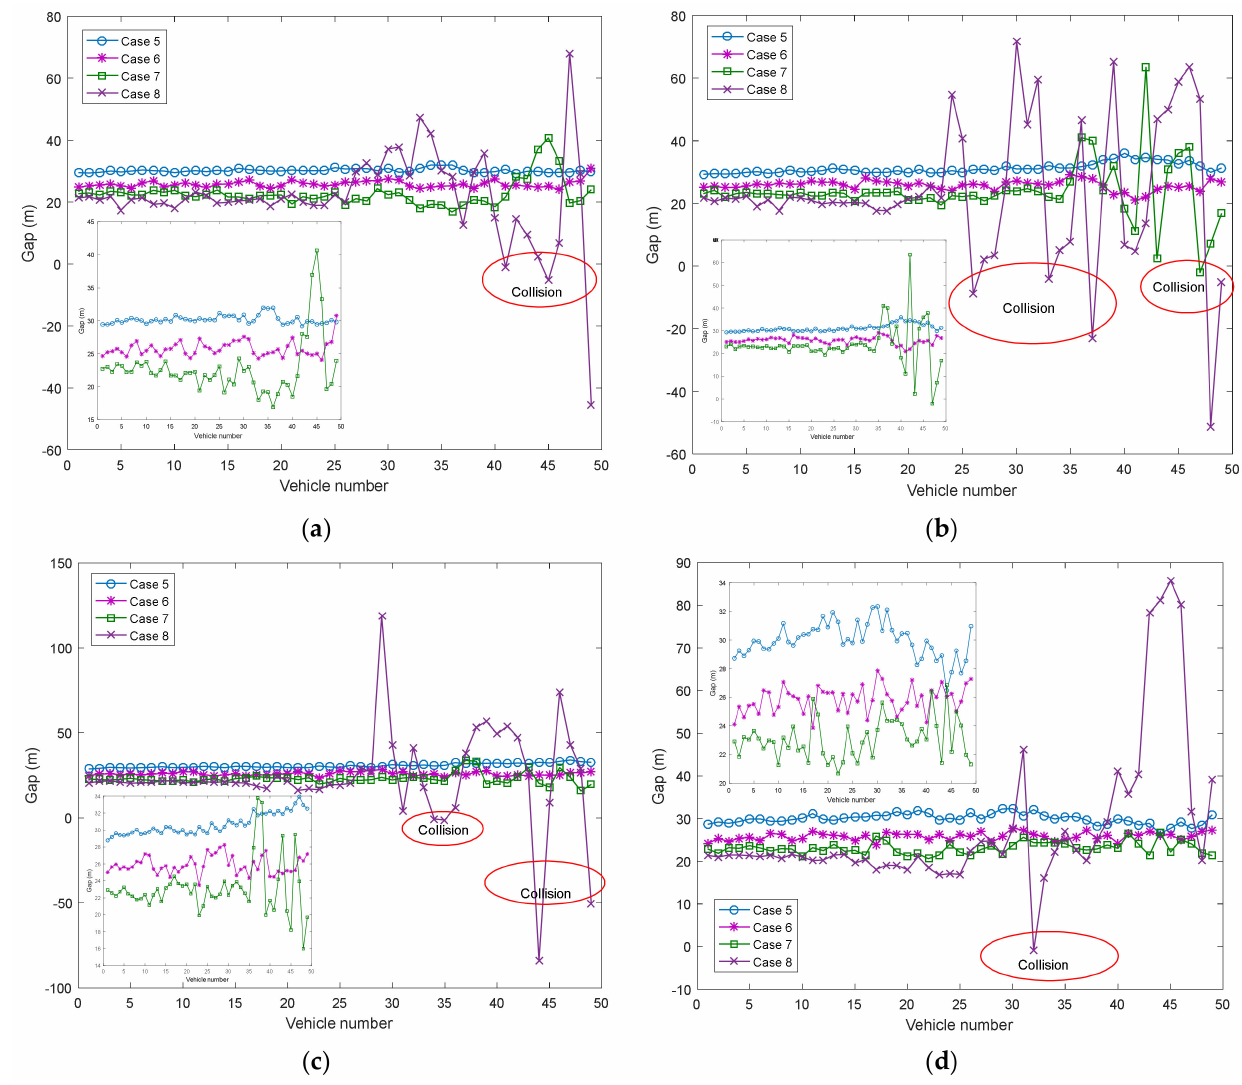
Figure 7. Gap patterns of all vehicles with DBCs at: ( a ) t = 300 s; ( b ) t = 500 s; ( c ) t = 800 s; ( d ) t = 1000